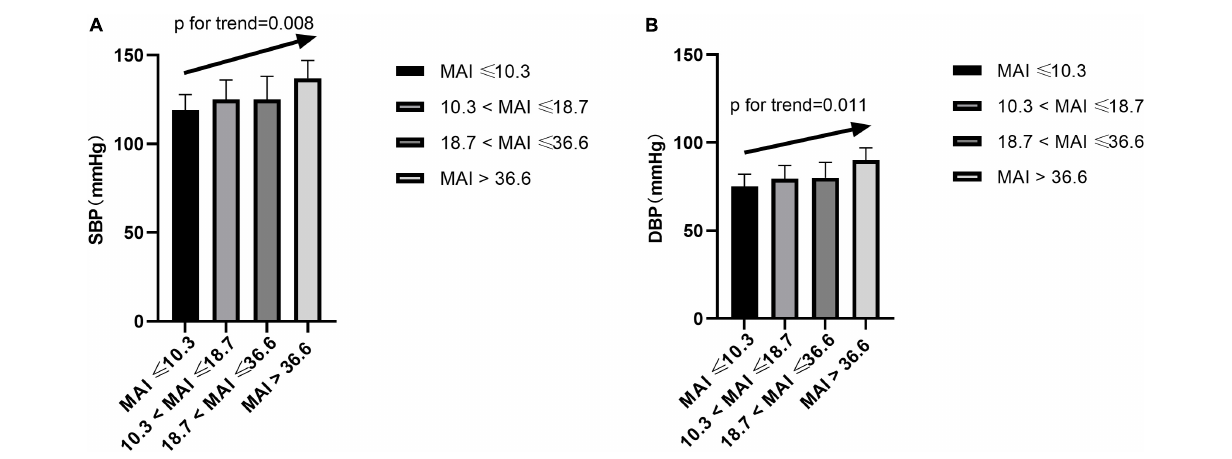
FIGURE 3 | Blood pressure across MAI quartiles. SBP, systolic blood pressure; DBP, diastolic blood pressure; MAI, microarousal index.